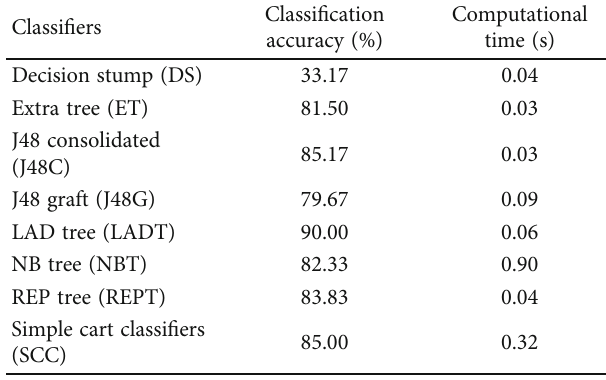
Figure 6: Number of features vs. classi fi cation